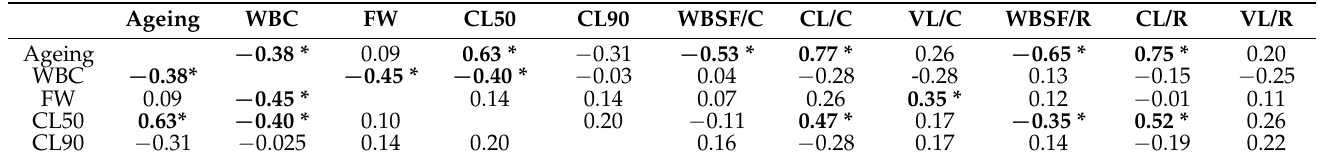
Table 4. Pearson’s correlation coefficients between variables determined in the study in fallow deer